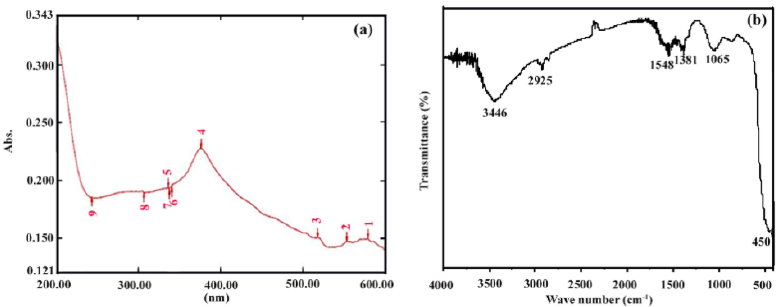
Figure 2. ( a ) UV-vis spectrum and ( b )FT-IR spectrum of bio-synthesized N-ZnO